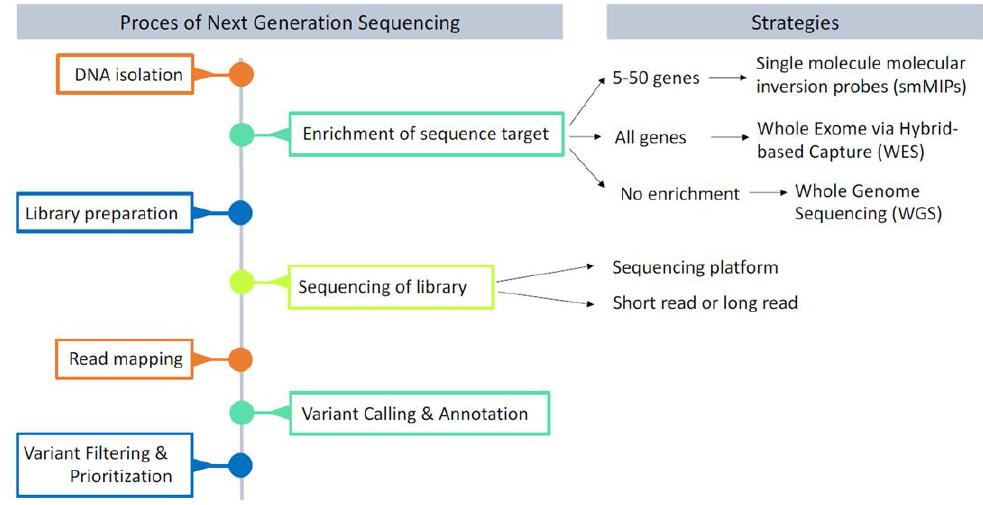
Figure 4. Stepwise delineation of the next-generation sequencing approach.